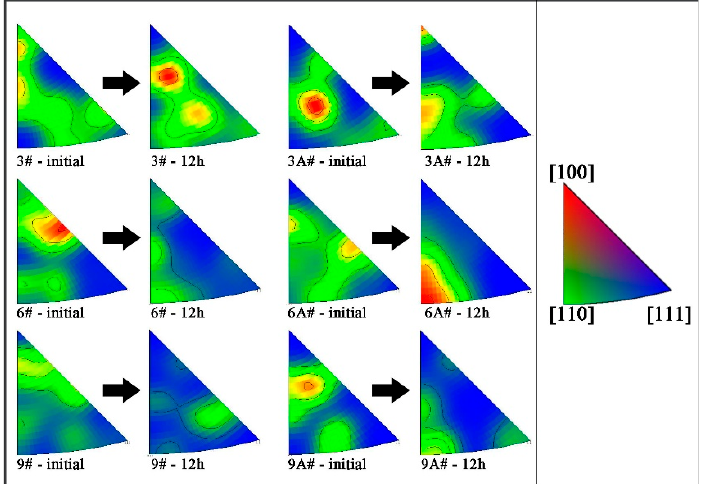
Figure 7. Inverse pole figure evolution in Z direction during creep, with EBSD data obtained in Z – Y cross-section.